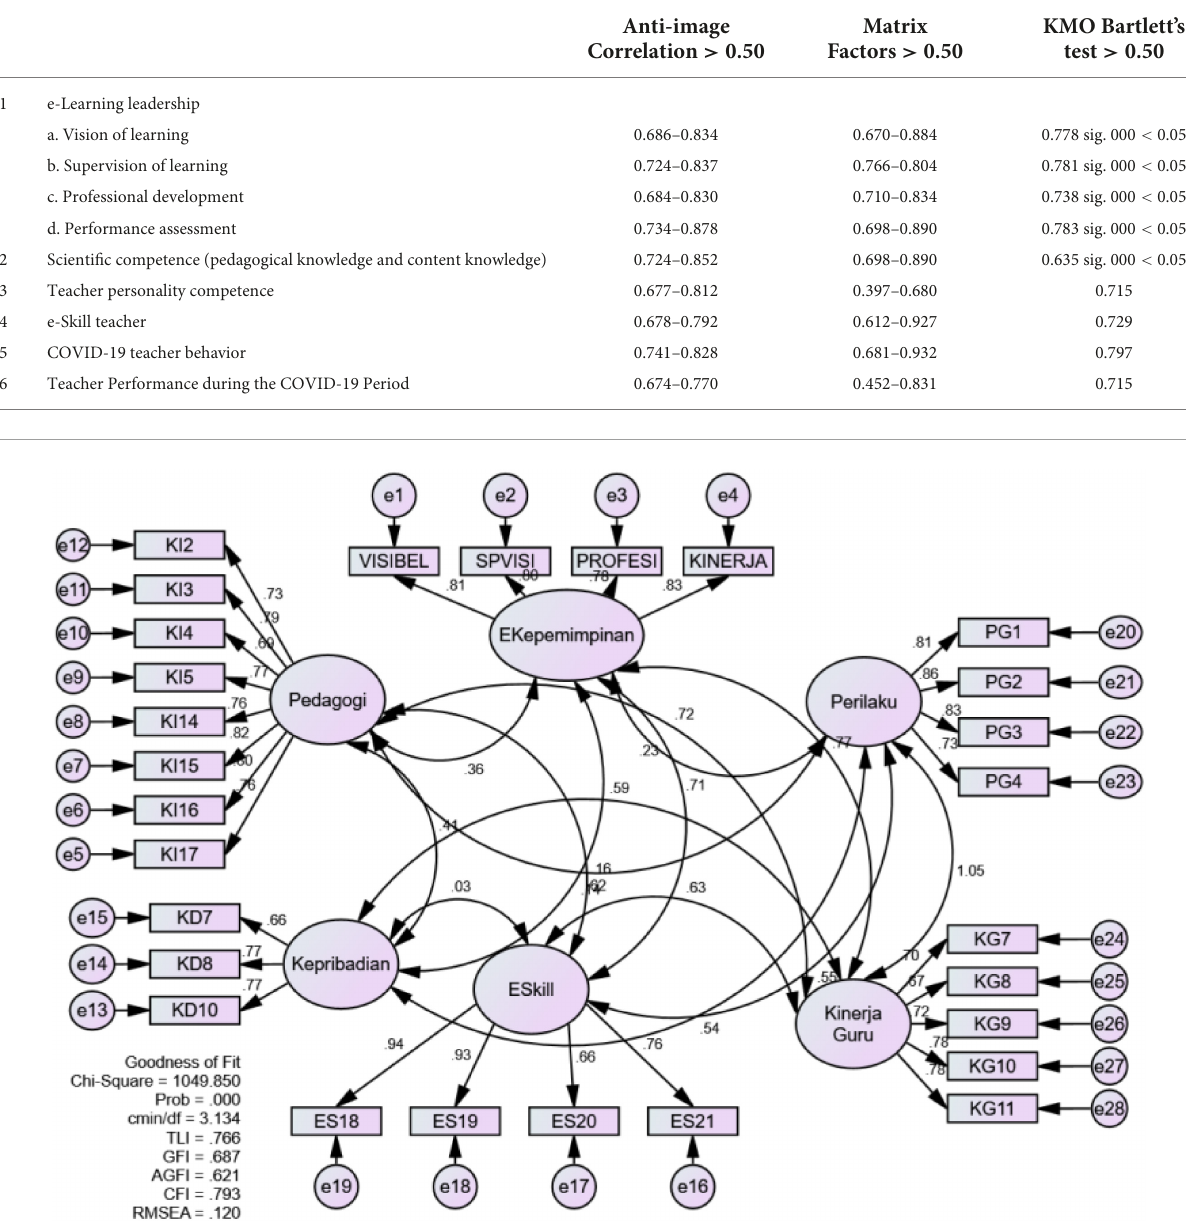
TABLE 3 Summary of validity test results with factor analysis.